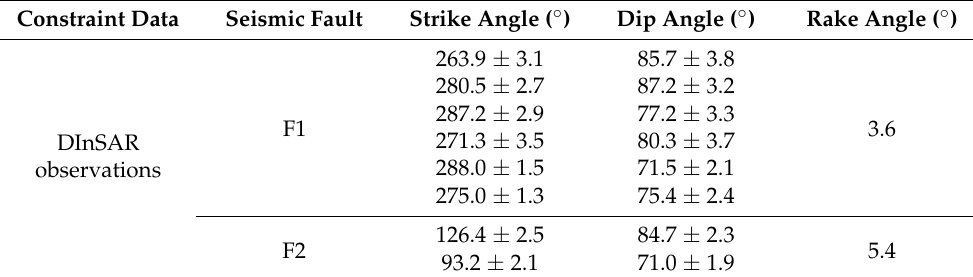
Table 4. Fault parameters of the 2021 Maduo earthquake solved by DInSAR observations. Constraint